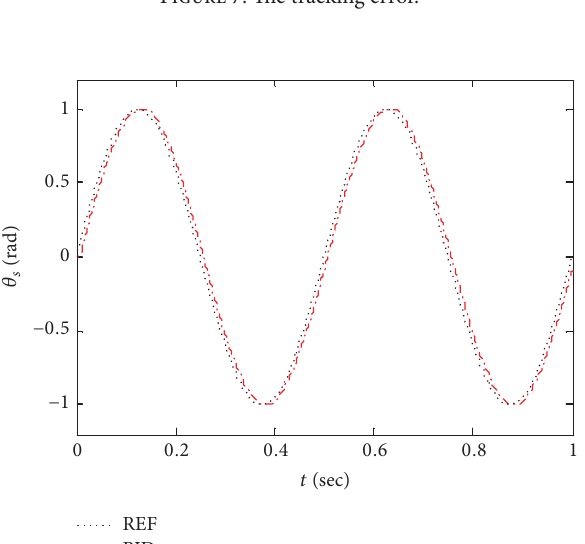
Figure 7: The tracking error.